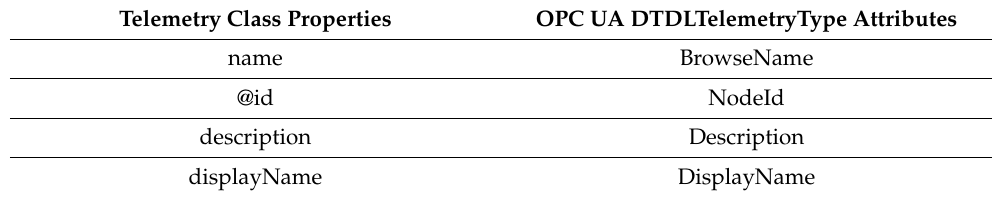
Table 6. Mapping of properties of the Telemetry class into OPC UA DTDLTelemetryType